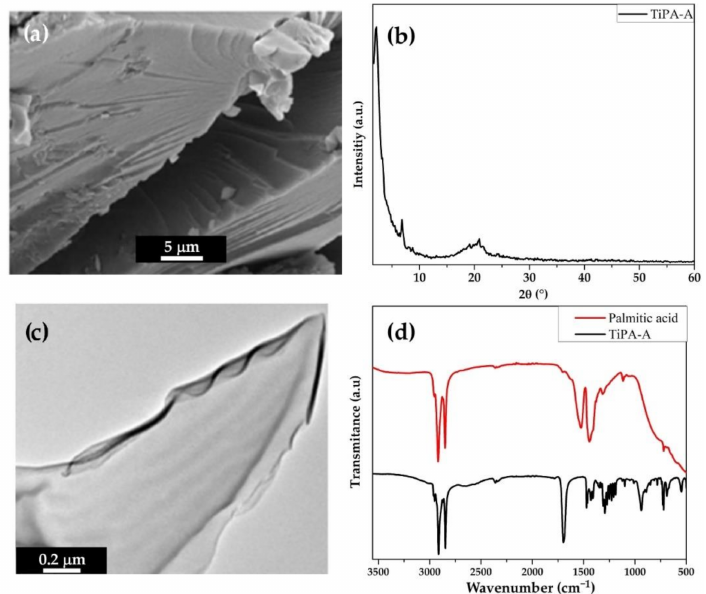
Figure 2. SEM ( a ), XRD diffractogram ( b ) and HTREM ( c ) of TiPA–A; and comparison of FTIR spectra of TiPA–A (red) and free palmitic acid (black) ( d